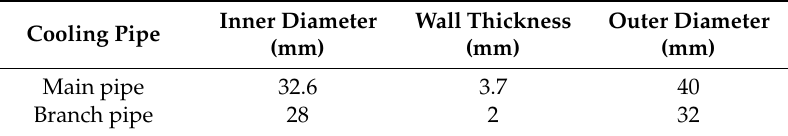
Table 2. Specifications of the cooling pipes.